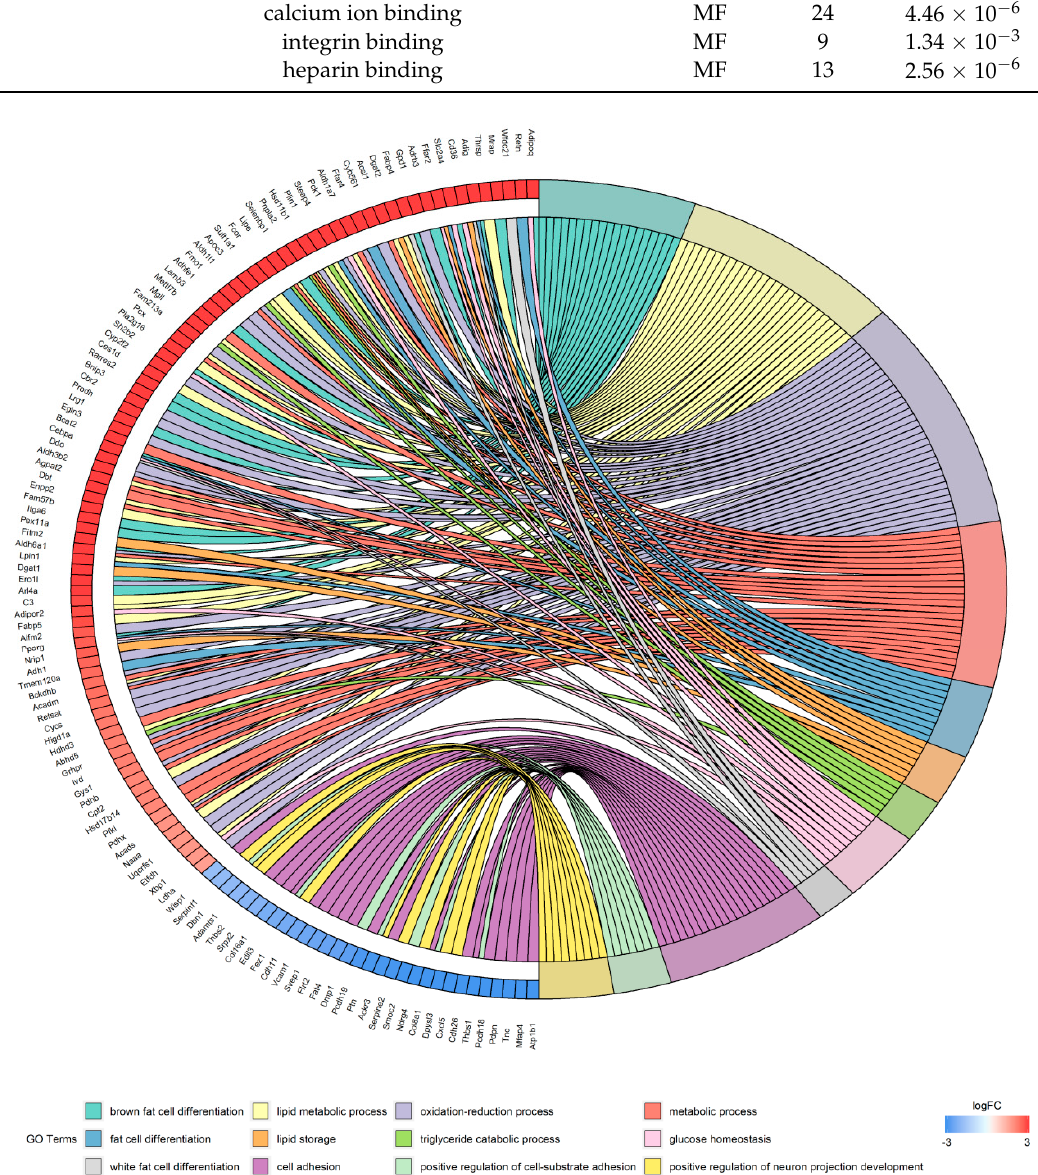
Figure 3. Distribution of genes that are up- and down-regulated during adipogenesis for different GO biological processes.